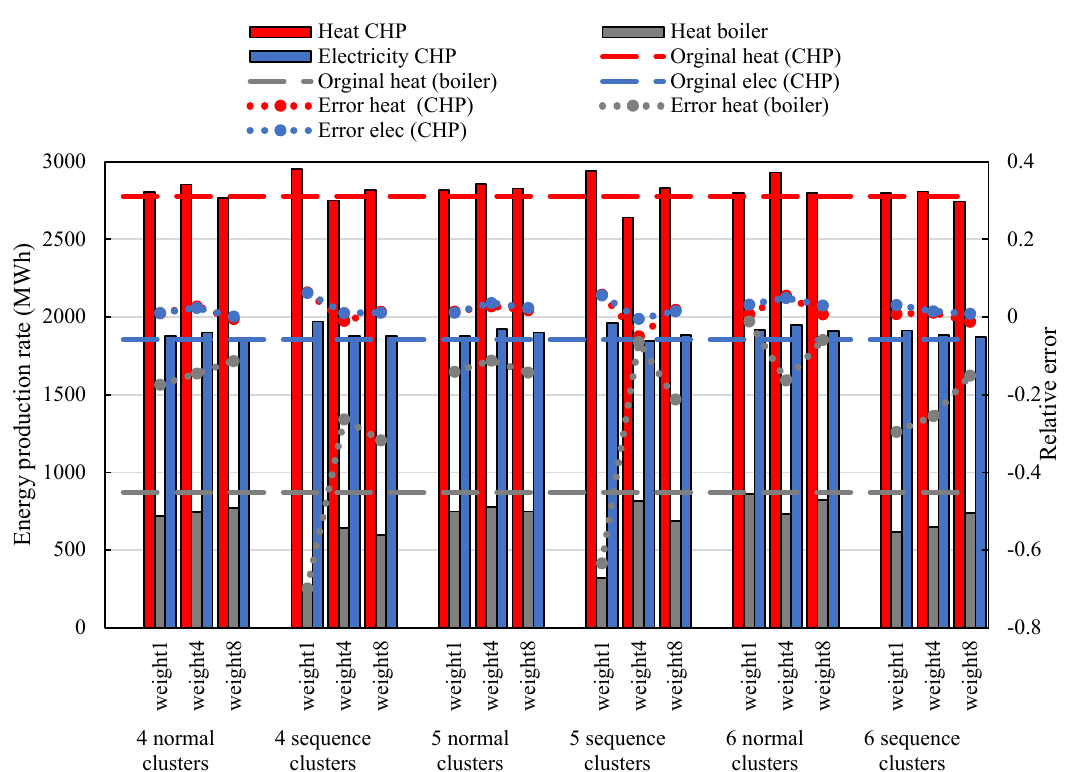
Figure 14. Comparison between the original and clustered models’ utility production rates from fossil-powered units under the GHG emissions constraint.